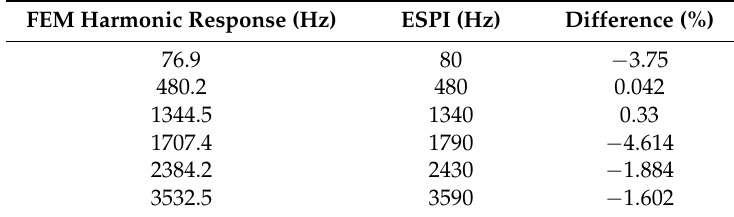
Figure 11. Natural frequency from simulation (unit: m); ( a ) without piezo properties = 75.4 Hz; ( b ) with piezo properties = 76.9 Hz.